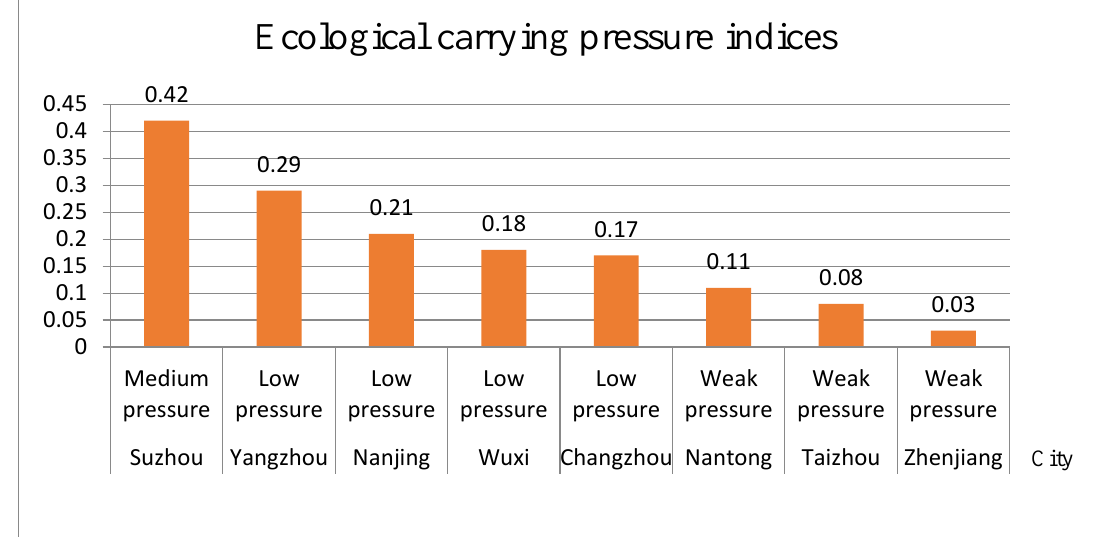
Figure 3. Histogram of ecological carrying pressure indices for Yangtze River urban agglomeration.